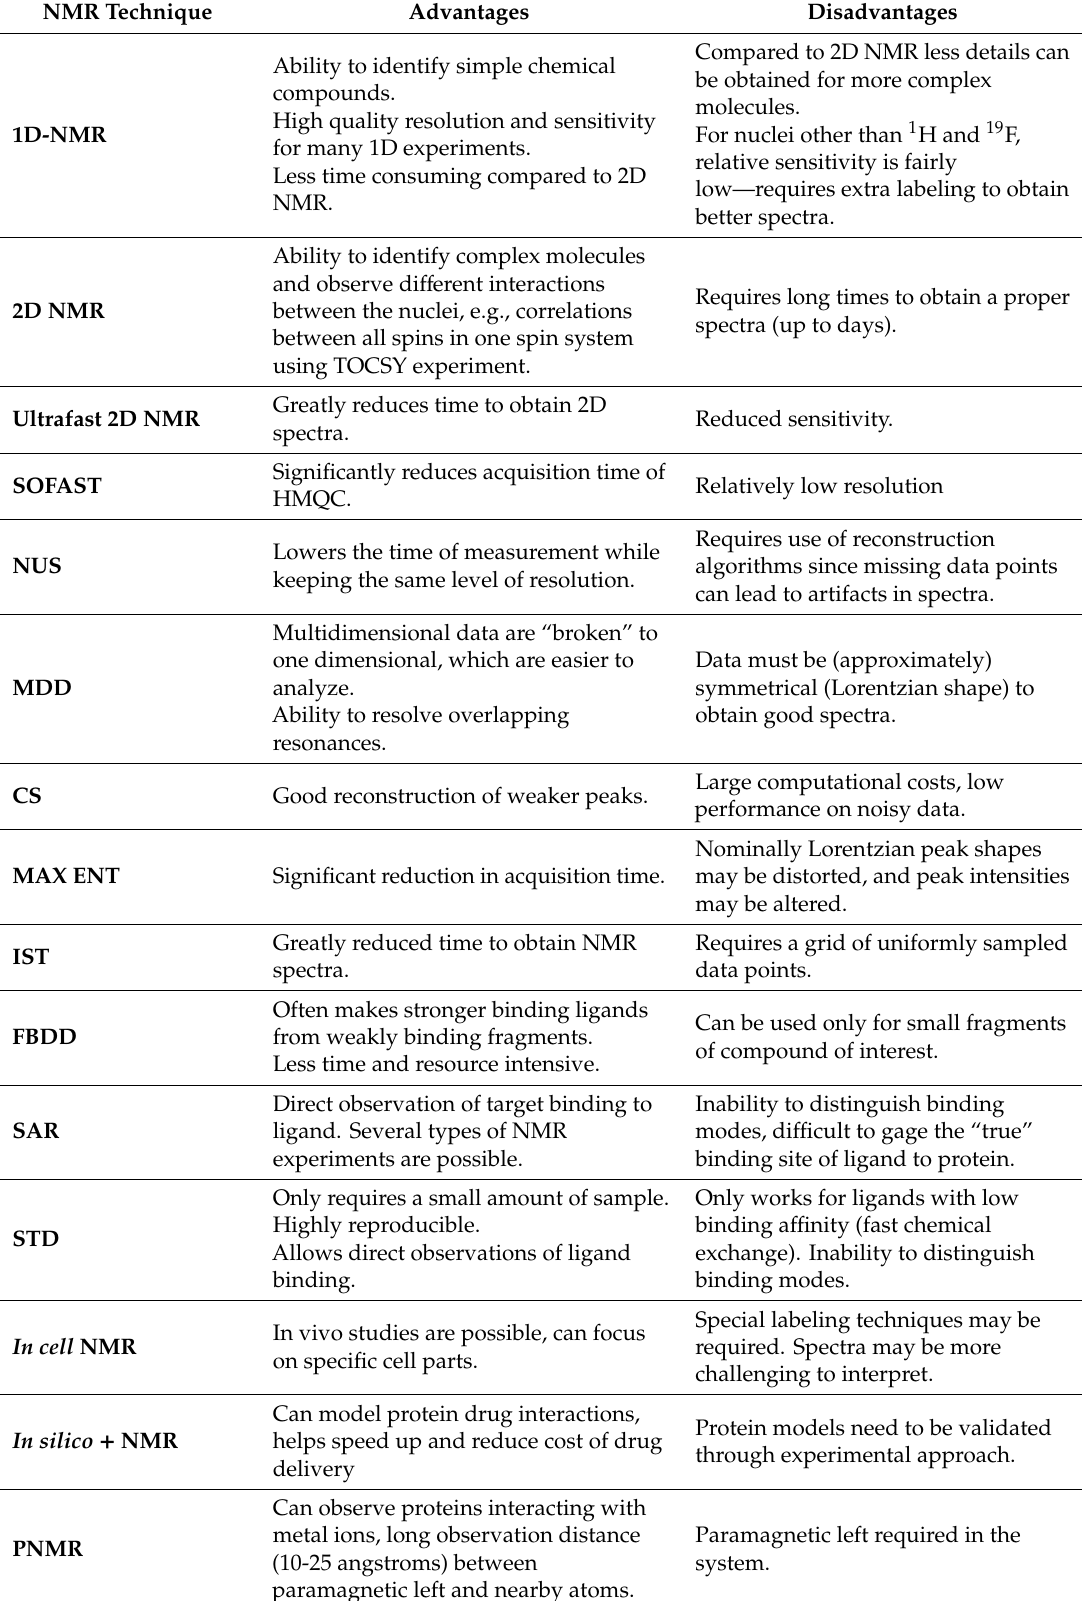
Table 3. Advantages and limitations of di ff erent NMR techniques developed in recent